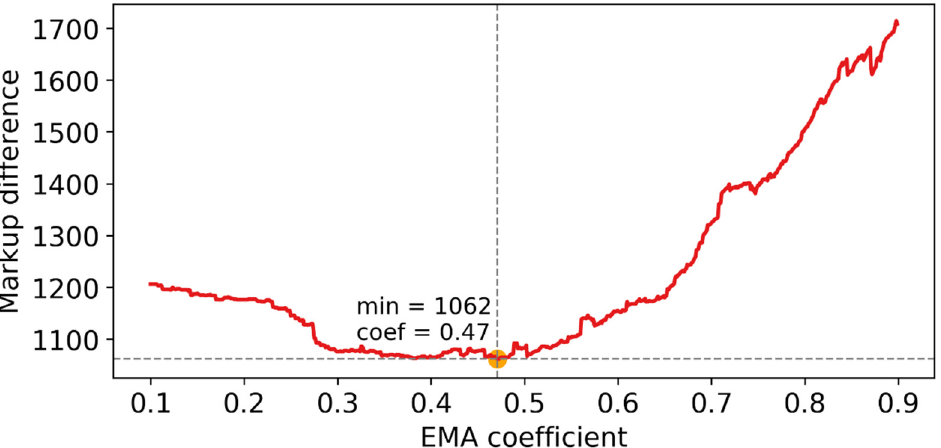
Figure 2. The figure shows how the total deviation of the event boundaries marked by the expert depends on the event boundaries found by the algorithm for different values of the EMA